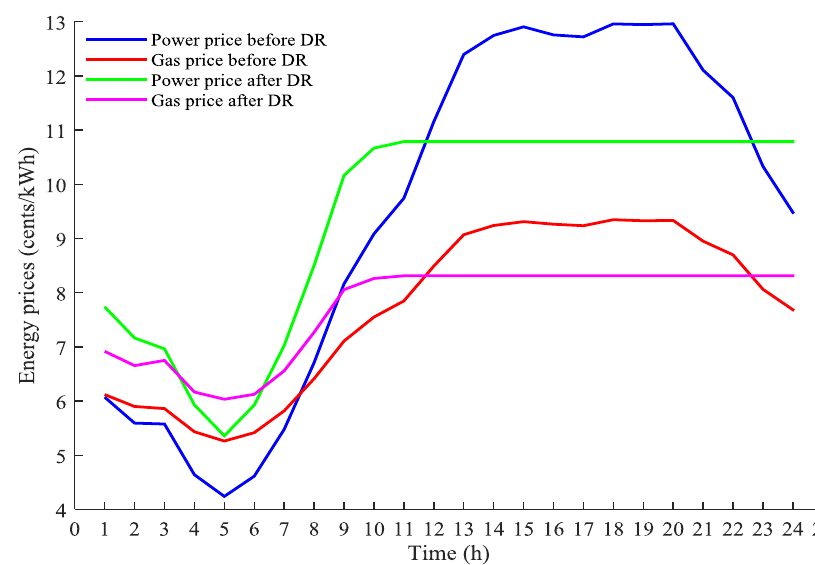
Energies 2018 , 11 , x FOR PEER REVIEW Figure 5. Real time power and gas prices before and after the demand response (DR).